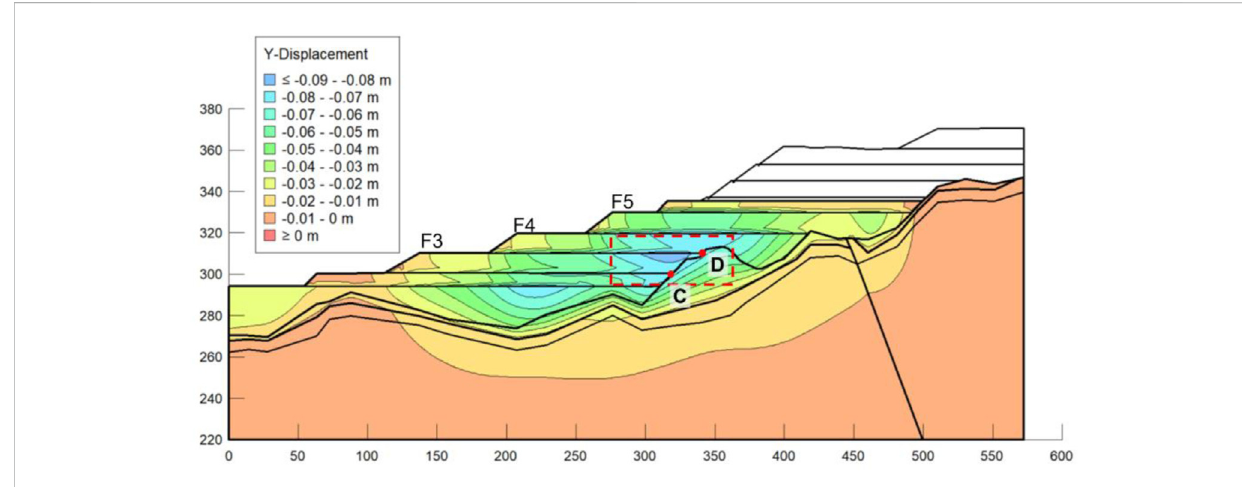
FIGURE 9 Cumulative displacement distribution contour of the high- fi lled deposit slope in the y-direction after the F area fi lling